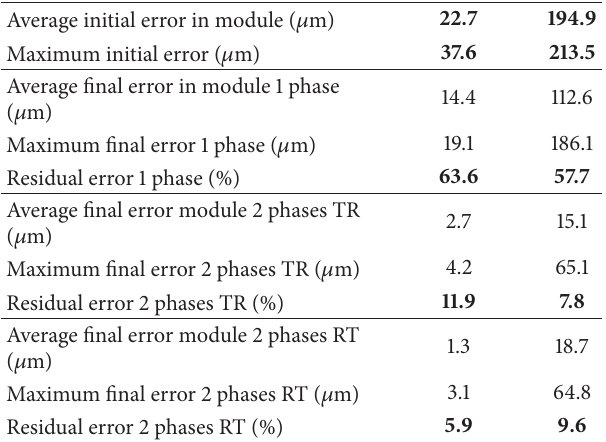
Table 6: Results of rotational axis verification in XCFZ machine. Table 7: Discretization of the work space to linear axis of XCFZ